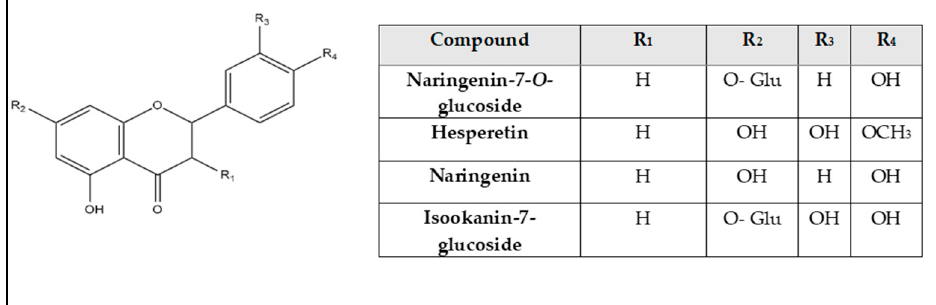
Figure 1. Structures of fl avones, fl avones glycosides, fl avonols, and fl avonols glycosides (Glu = glu- coside, Gal = galactoside, Rha = rhamnose, Ara = arabinose, Xyl = xylose, Neo = neohesperidoside, Rut = rutinoside).